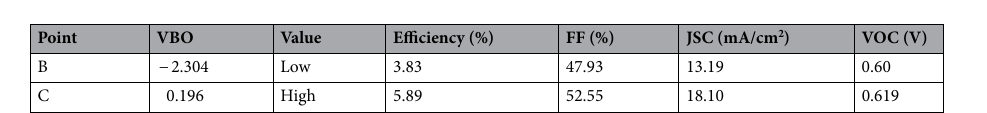
Table 1. Simulation characteristics of the CBT (S, Se) solar cells by utilizing the In 2 S 3 electron transport layer as a function of